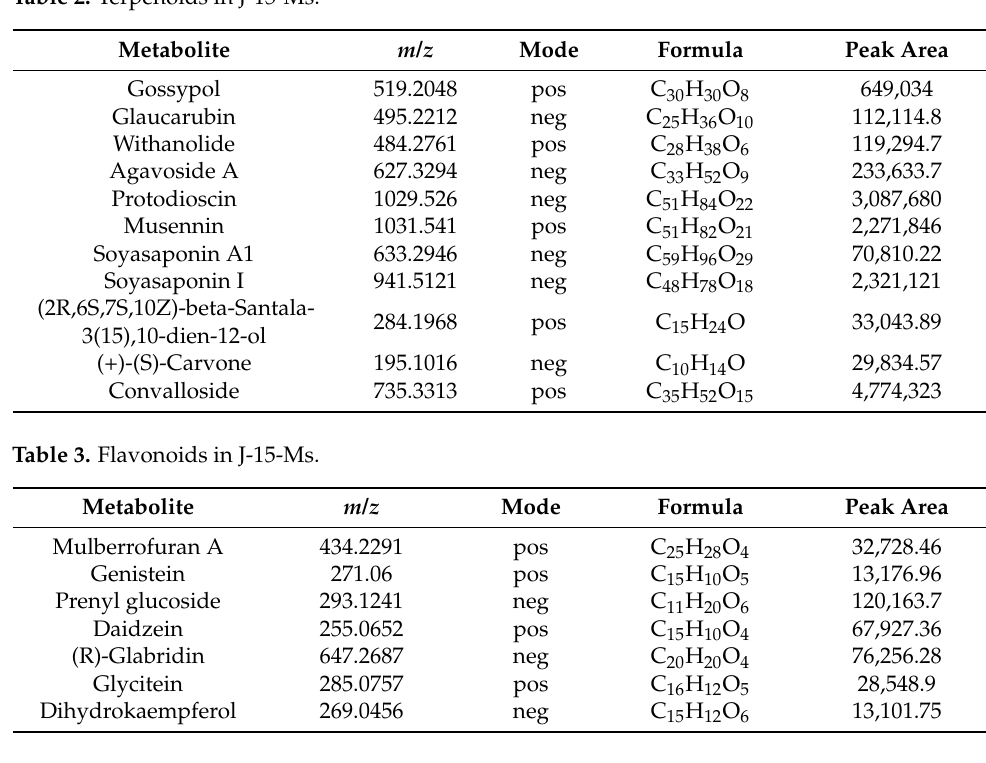
Table 4. Hormonal substance in